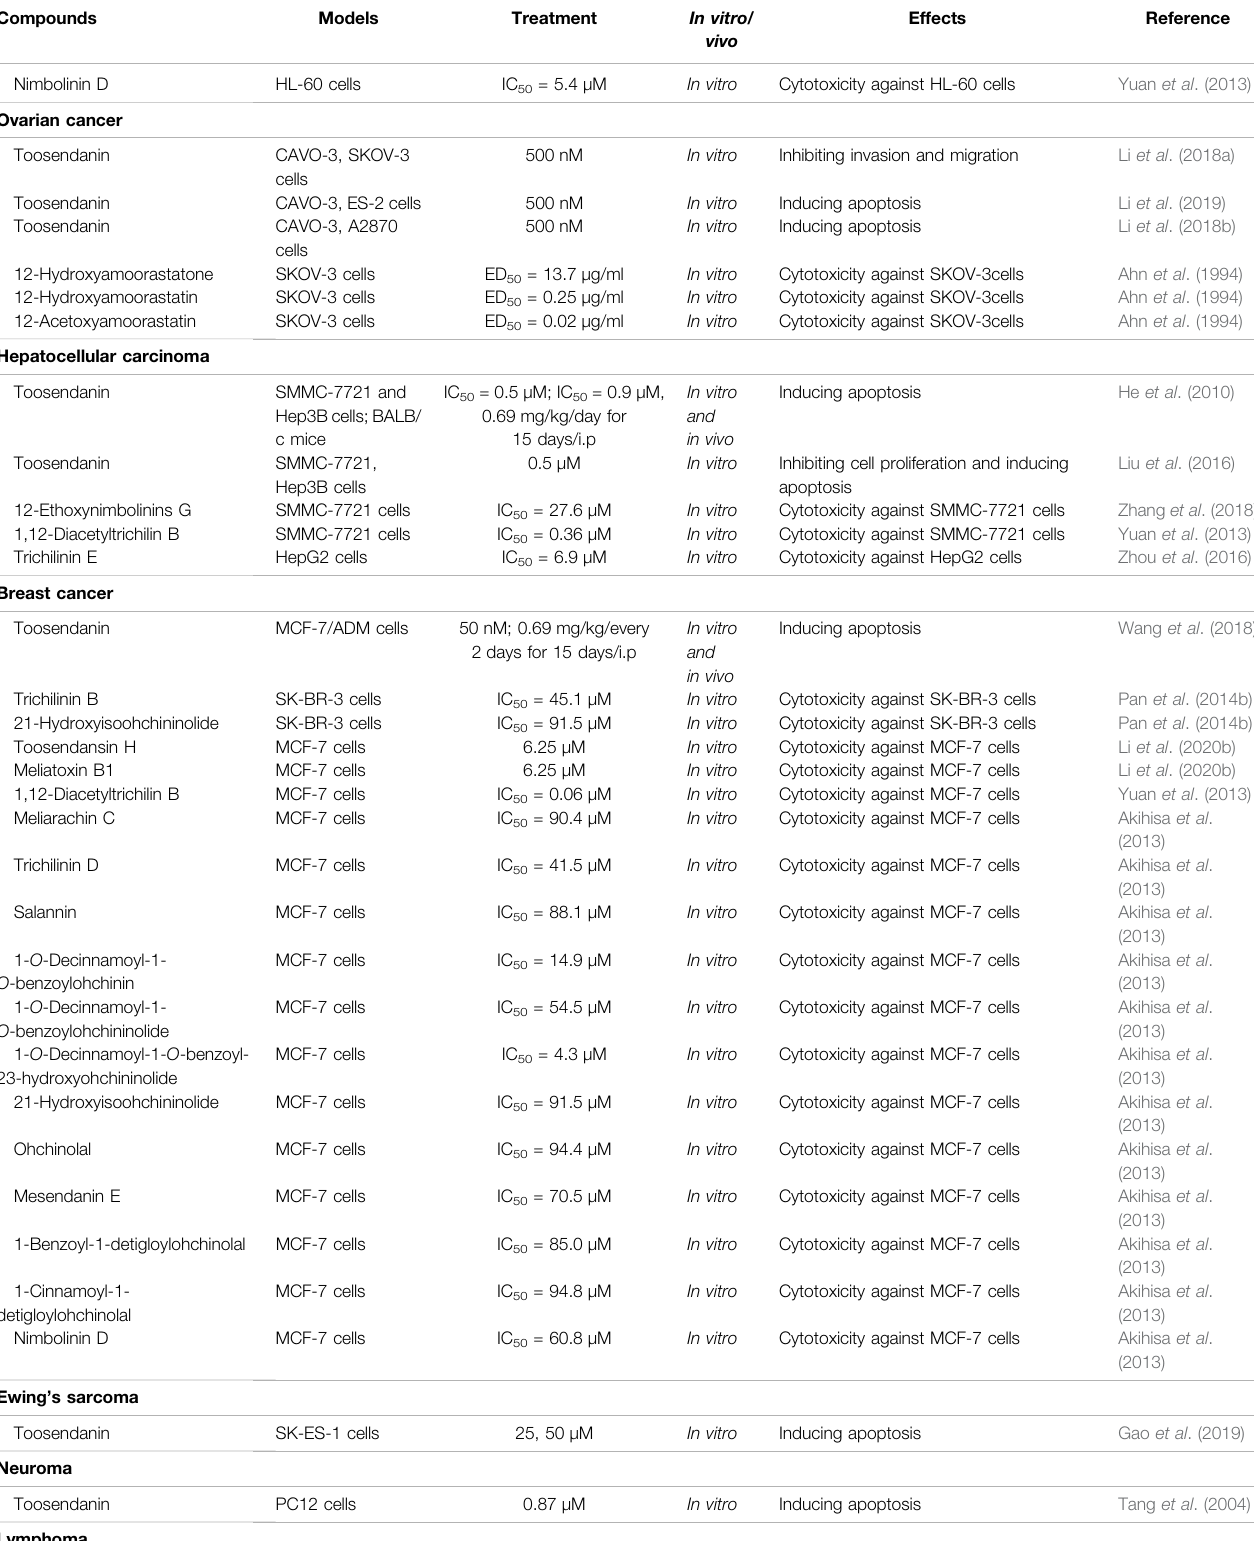
TABLE 2 | ( Continued ) Pharmacological effects of